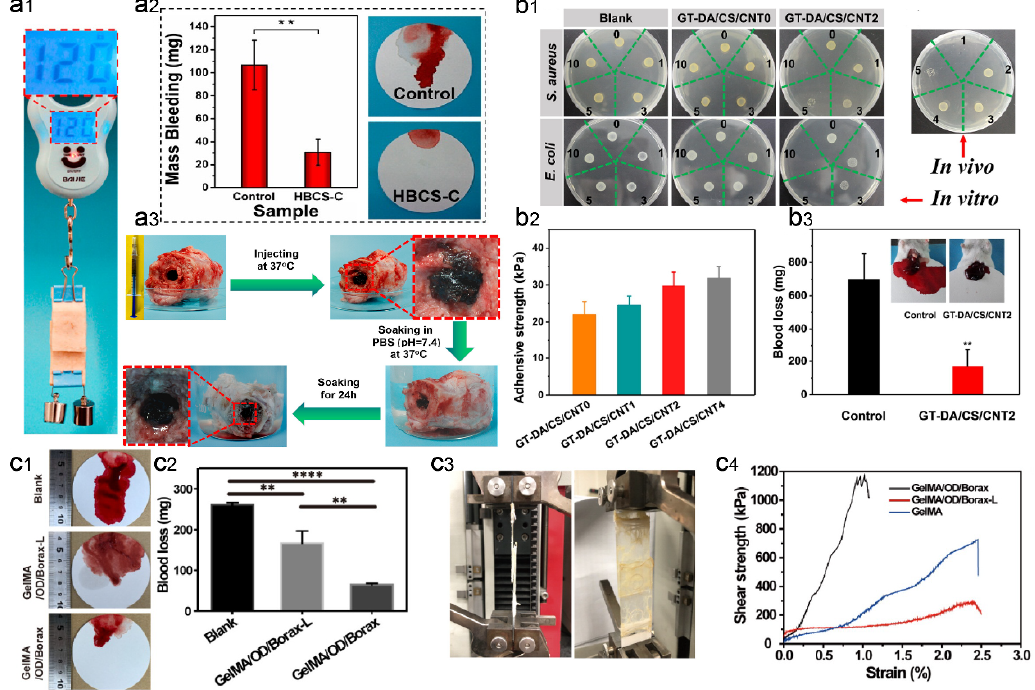
Figure 8. Wet-adhesive hemostatic hydrogel in liver wounds. ( a ) Tissue adhesion and hemostatic effect of HBCS-C hydrogel. Reprinted (adapted) with permission from [100]. Copyright {2020} American Chemical Society. ( a1 ) The images show good adhesion of HBCS-C hydrogel on porcine skin (adhesion area of 20 mm × 20 mm and heavy load of 120 g). ( a2 ) Total blood loss from liver wounds in hydrogel-treated and untreated rats. ( a3 ) Photographs showing the wet bioadhesive behavior and stability of HBCS-C hydrogels in an aqueous environment at 37 ◦ C. ( b ) Antimicrobial, adhesion, and hemostatic properties of GT-DA/CS/CNT hydrogel. Figure modified from [102] with permission. ( b1 ) In vitro antibacterial activity of hydrogels induced by NIR illumination, 0, 1, 3, 5, and 10 represent different irradiation times (min). ( b2 ) Adhesion strength of the hydrogels after 1 h in the air before testing. ( b3 ) Hemostatic ability of GT-DA/CS/CNT hydrogels. ( c ) Adhesion and hemostatic properties of GelMA/oxidized dextran/Borax hydrogels. Figure modified from [101] with permission. ( c1 ) Photographs of liver blood loss after different treatments. ( c2 ) Blood loss during hemostasis of the liver. ( c3 ) Pictures of the modified test method used for the overlapping shear test. ( c4 ) Strain–stress curves for the overlapping shear test. (** p < 0.01, **** p <